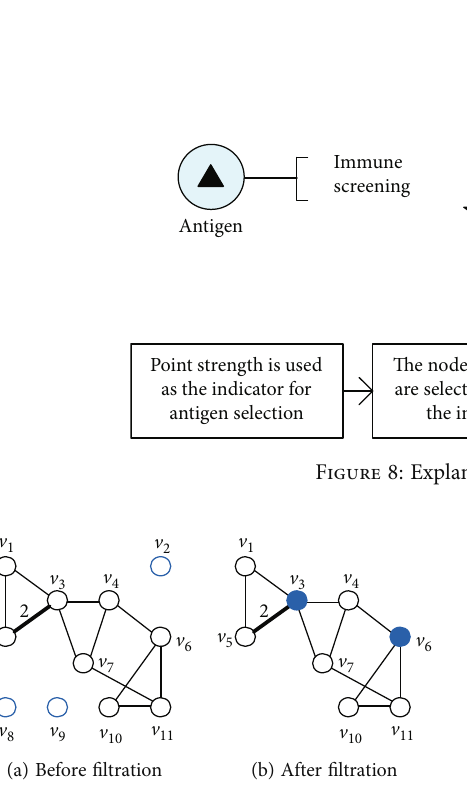
Figure 9: Filters isolated